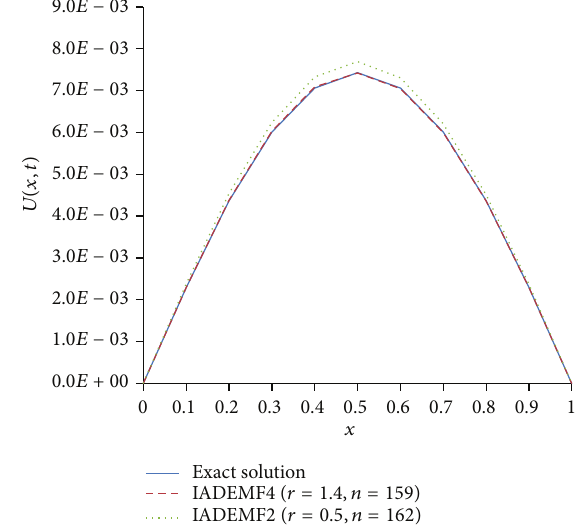
Figure 7: Numerical and exact solutions for Experiment 1. 𝜆 = 1.0 , Δ𝑥 = 0.1 , Δ𝑡 = 0.01 , 𝑡 = 0.5 , and 𝜀 = 10 −4 .